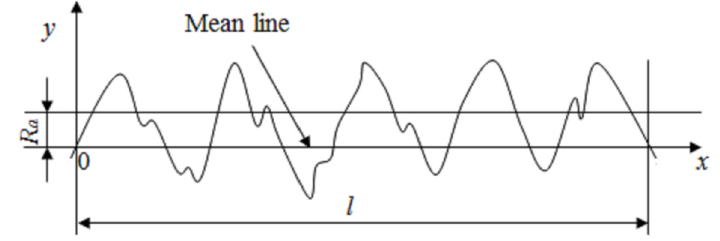
Figure 5. Graphical representation of roughness parameter Ra .